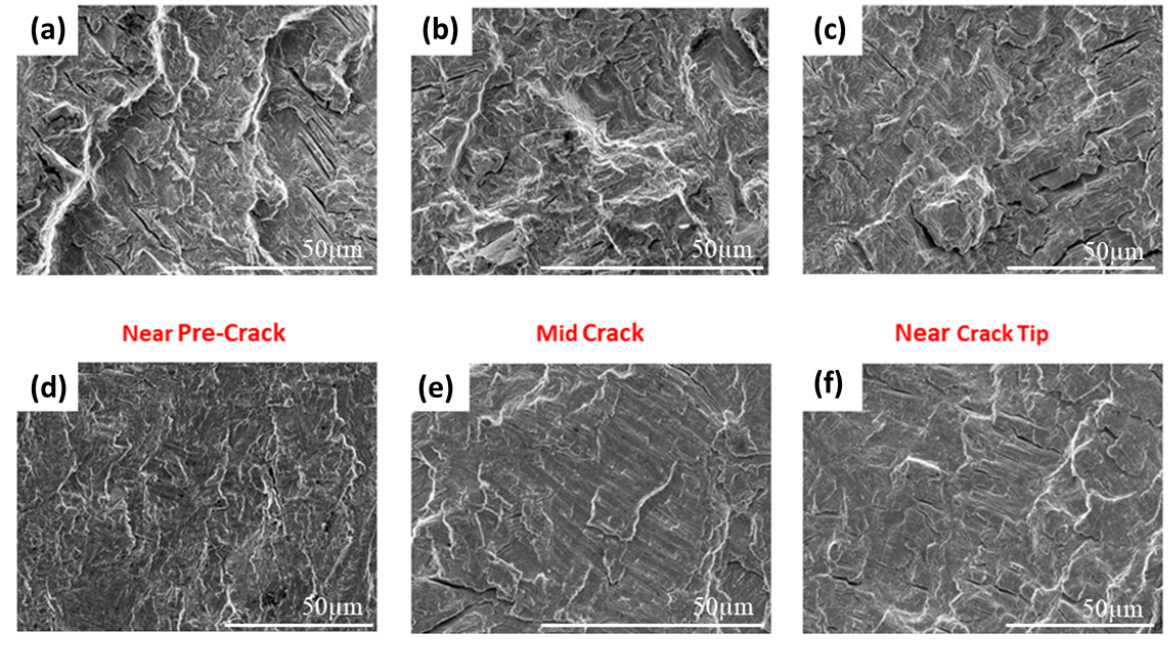
Figure 12. Fractography of TMFCG IP 200–500 °C ( a ) near pre-crack ( b ) mid crack ( c ) near crack tip and TMFCG OP 200–500 °C ( d ) near pre-crack ( e ) mid crack and ( f ) near crack tip .